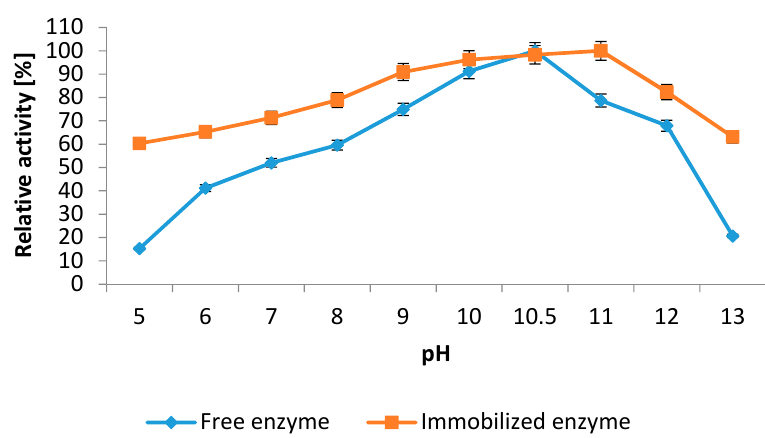
Figure 6. Effect of pH on the activity of the free and immobilized NPST-AK15 protease. Enzyme activity was measured at 55 °C. The results represent the mean of three separate experiments, and error bars are indicated.